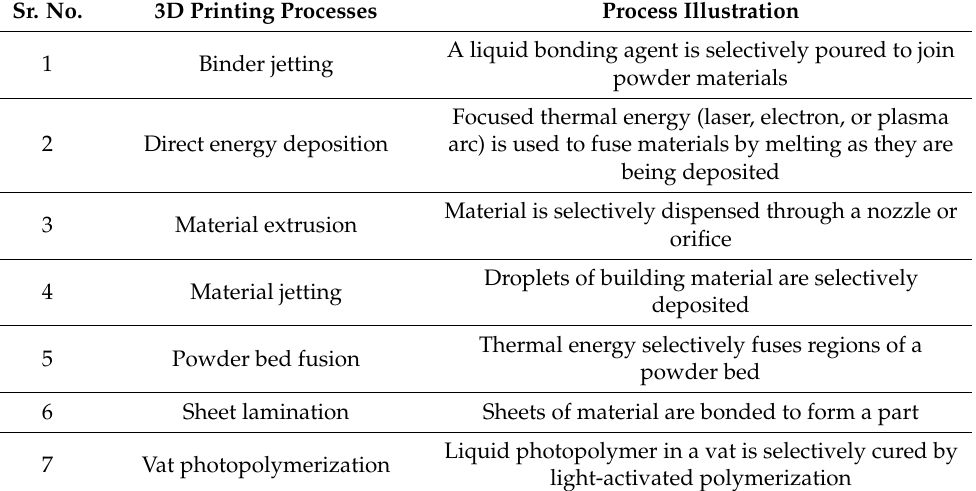
Table 1. Various 3D printing processes